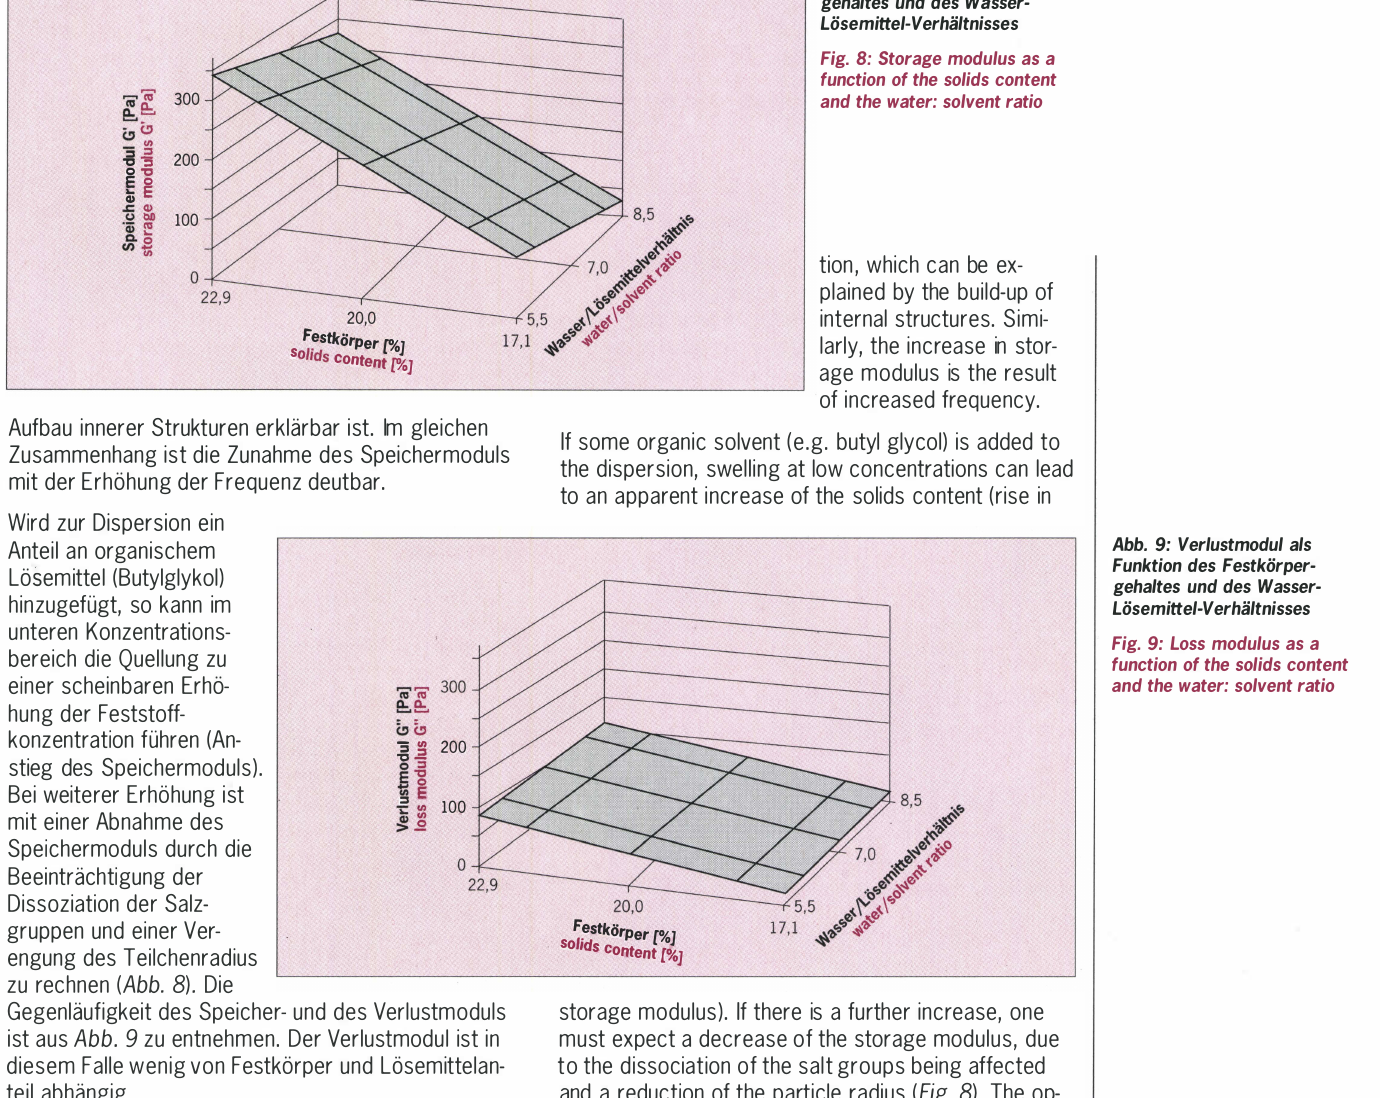
Fig. 8: Storage modulus as a function of the solids content and the water: solvent ratio